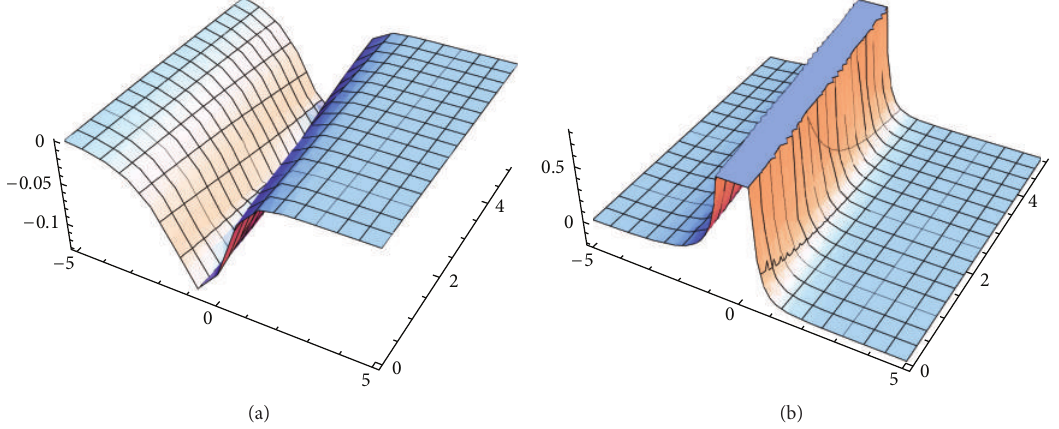
Figure 2: Graph of the solution 𝑢(𝑥,𝑡) from left to the right for (15) and